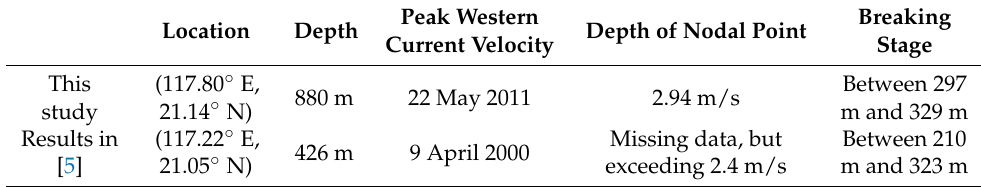
Table 1. Observations in this study and in